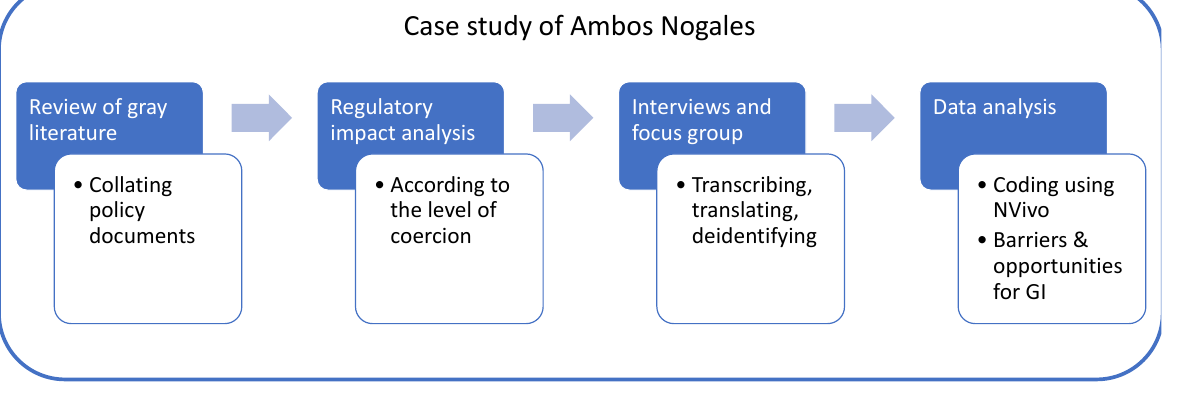
Figure 1. Methodology chart showing the steps of the research design (credit: Schwartz and Zuniga- Teran).